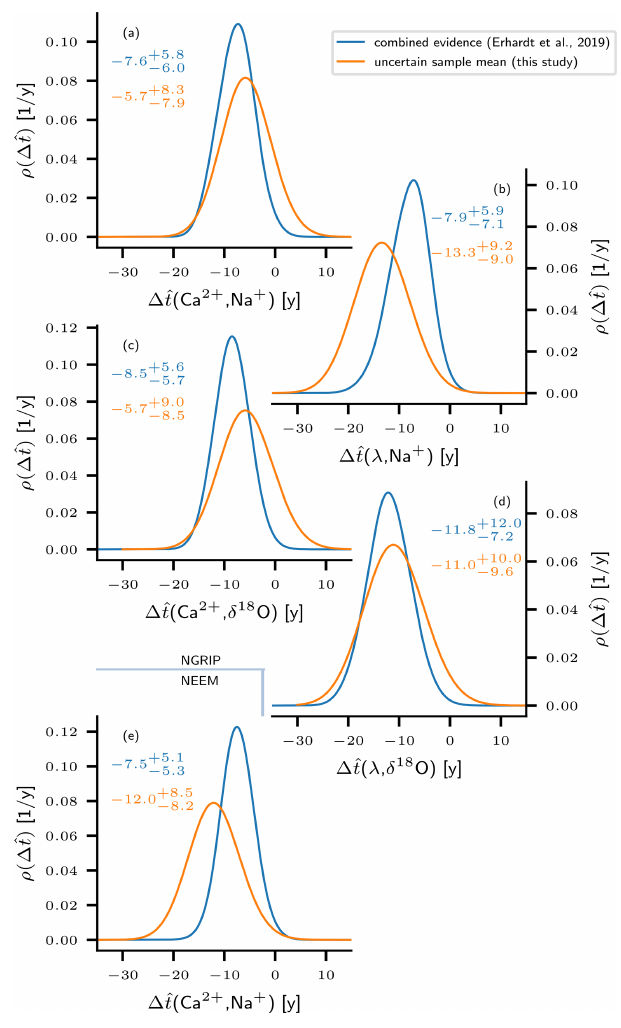
Figure 5. Comparison between the uncertain sample means (this study) and “combined estimates” according to Erhardt et al. (2019). The probability densities for the combined estimate are derived from the samples of uncertain time lags according to Eq. (34). Cor- respondingly, the uncertain sample means are computed according to Eq. (36). The numbers in the plots indicate the mean, the 5th, and the 95th percentile of the respective quantity. Both computations use Gaussian kernel density estimates of the MCMC-sampled tran- sition onsets lags. Panels (a–d) refer to proxy pairs from the NGRIP ice core, and panel (e) shows results from the NEEM ice core. The distributions for both the combined estimate and the uncertain sam- ple mean point towards a delayed transition onset in δ 18 O and Na + with respect to λ and Ca 2 +